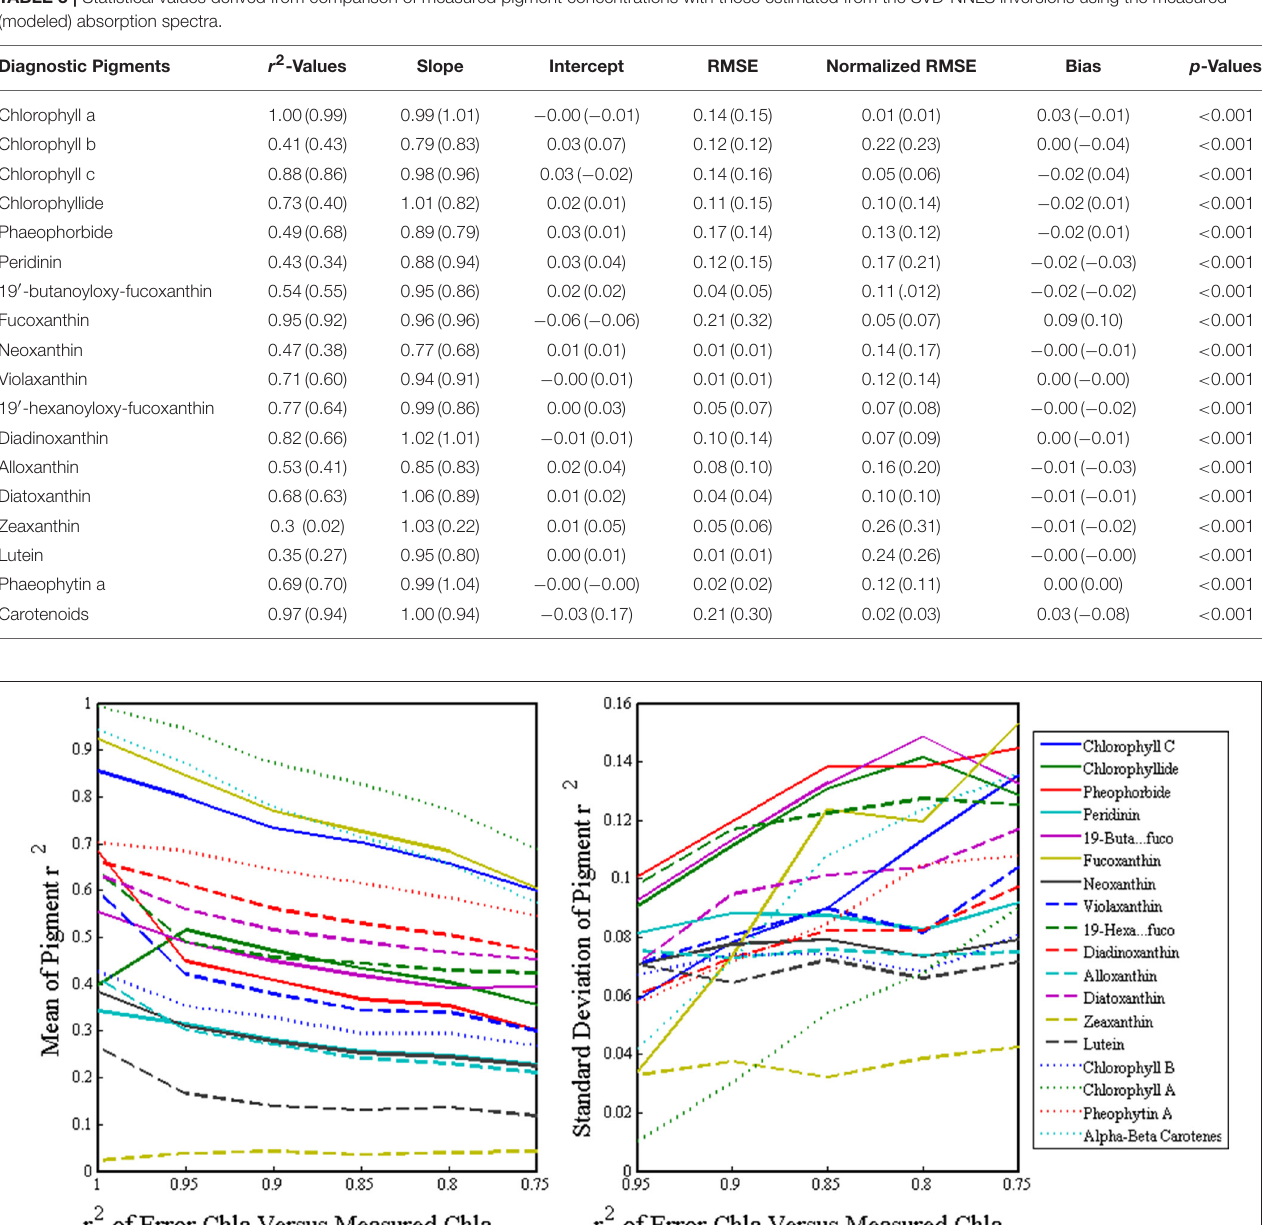
a levels observed in the coastal region and underestimates the lower chlorophyll a values found in the offshore region, thereby reducing the overall gradients in the true chlorophyll a fields. Such a cross-domain bias serves only to distort the resulting pigment retrievals by diminishing the gradients, while keeping distinguishable the larger scale pigment patterns and time series